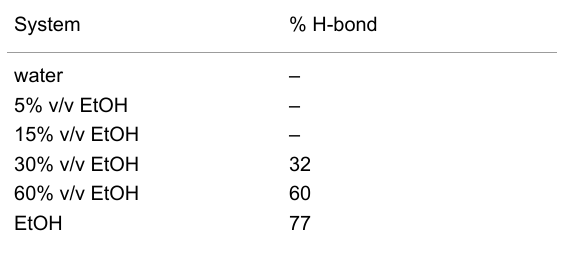
Table 4: Percentage of hydrogen bond (% H-bond) formed between the hydroxy groups of α -MGS and the β -CD